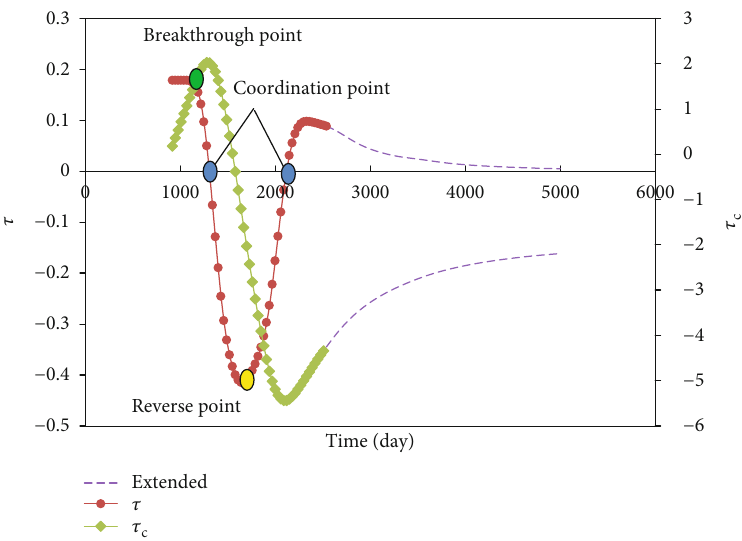
Figure 11: Water-polymer perturbation coe ffi cient.